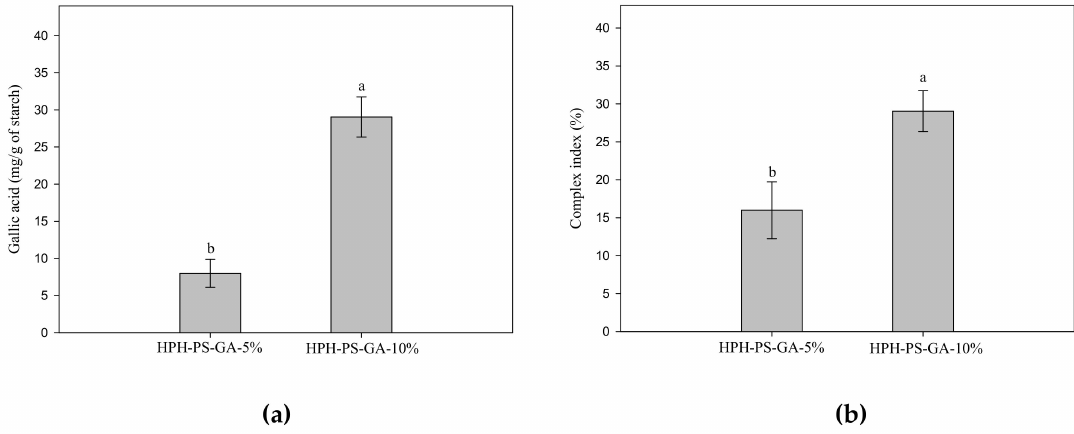
Figure 3. Gallic acid content ( a ) and complex index ( b ) of pea–gallic acid complexes made by high- pressure homogenization with 5% and 10% ( w / w ) gallic acid. The letters a and b indicate statistically significant difference at p < 0.05 between groups in the same